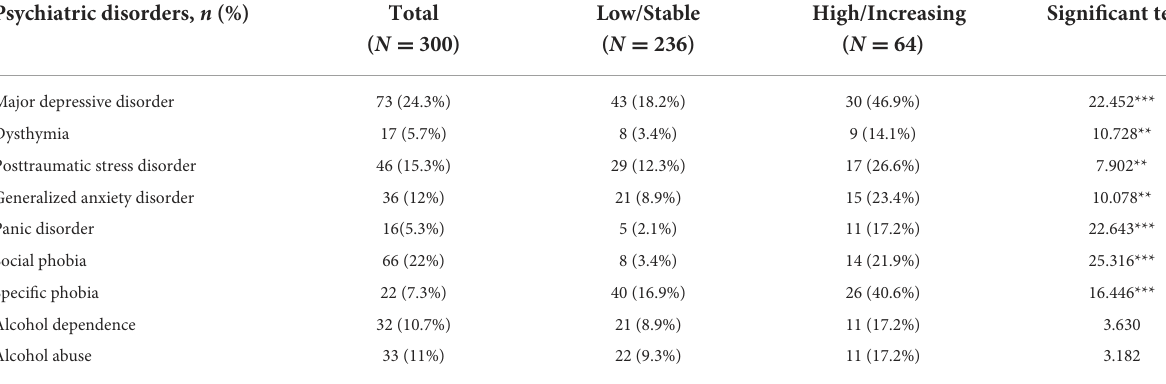
TABLE 4 Between-class comparison of prevalence of DSM-IV major mental disorders at baseline. Psychiatric disorders, n (%) Total